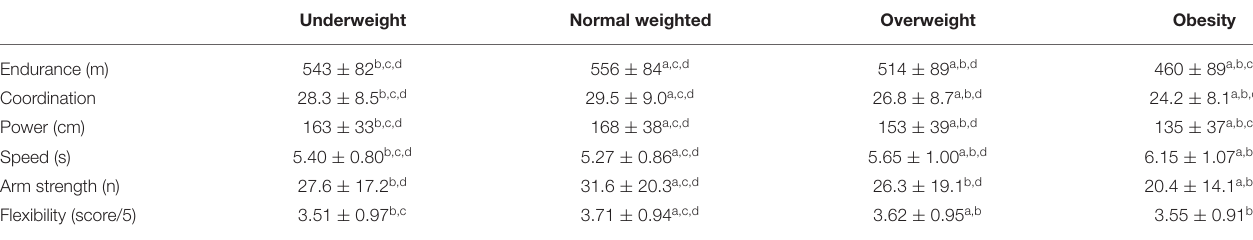
TABLE 2 | Performances during the tests of physical fitness according to class of body mass index. Underweight Normal weighted